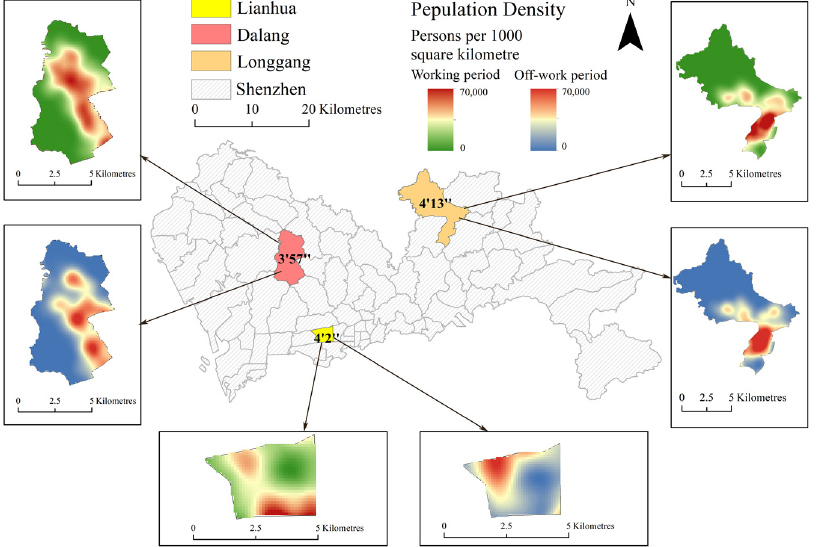
Figure 10. Distribution and population dynamics of Lianhua, Dalang, and Longgang subdistrict. The number within the subdistrict indicates the people’s average travel time to reach the nearest NAT site based on our scheme.